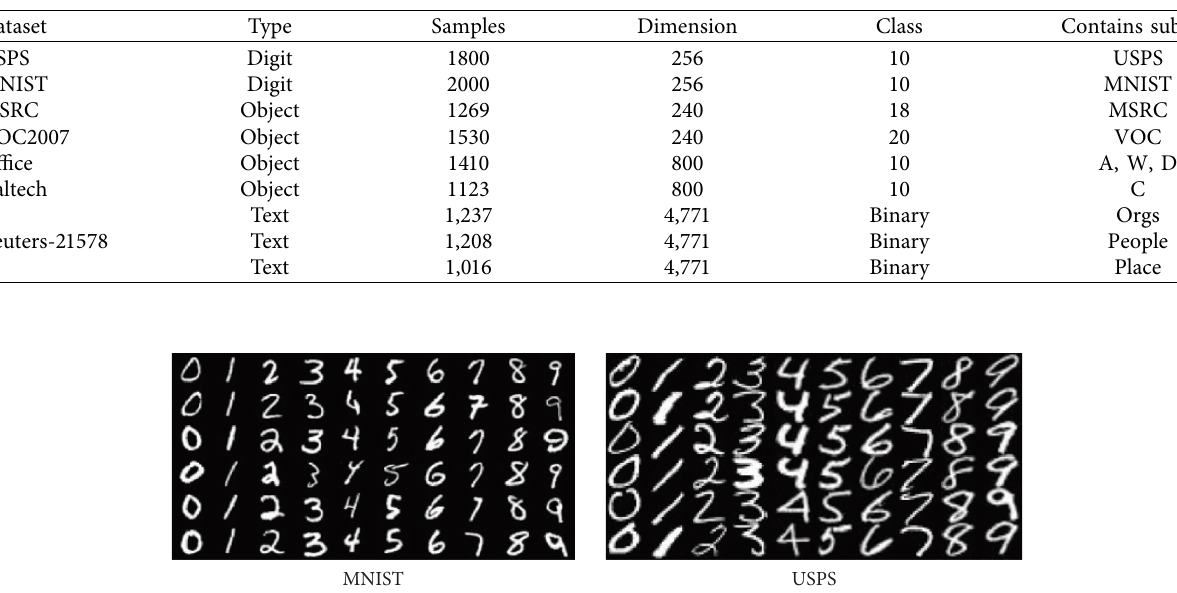
Figure 3: Image from MNIST and USPS